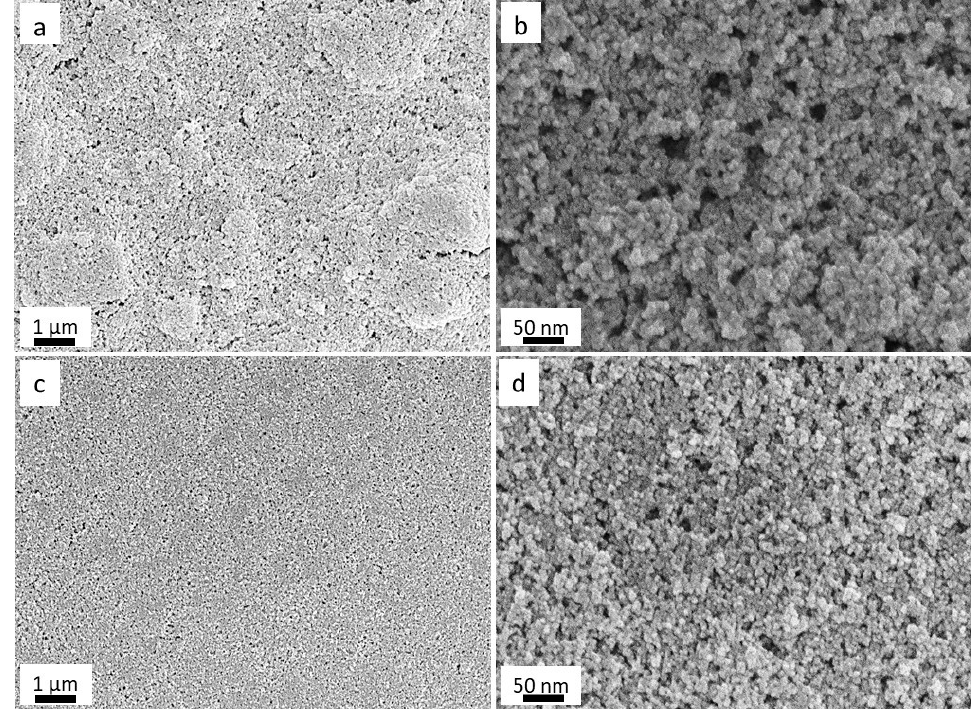
Figure 2. Microstructural characterisations of SANP-S and SANP-T photoanode films: ( a , b ) Low- and high-magnification SEM images of SANP-S; ( c , d ) Low- and high-magnification SEM images of SANP-T.